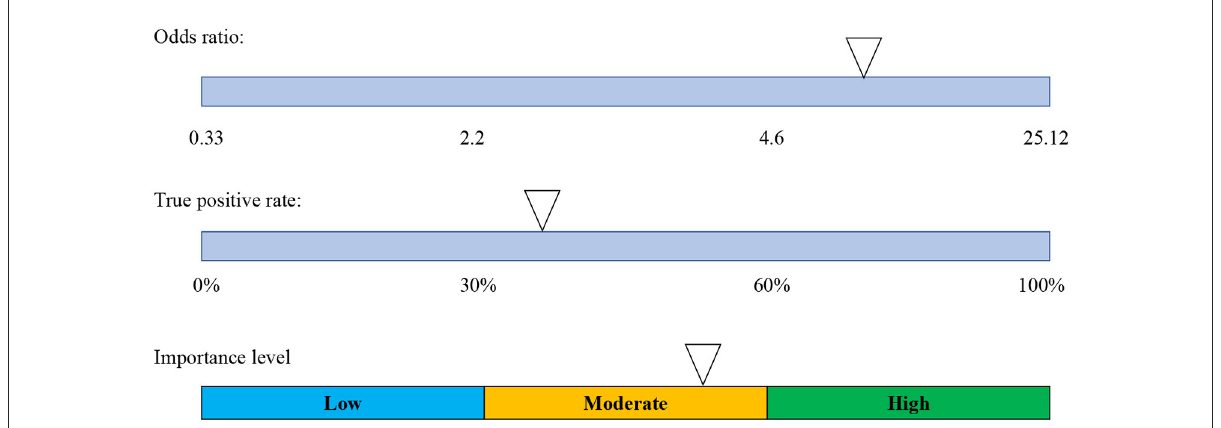
FIGURE1 A visual representation of the method used to determine the level of importance of a significant logical attribute. As can be seen, the importance level was determined by finding the midway point between the respective points (represented as arrows) on the odds ratio size and true positive rate scales. An attribute was thus considered highly important if the odds ratio was above 4.6 whilst simultaneously having a true positive rate above